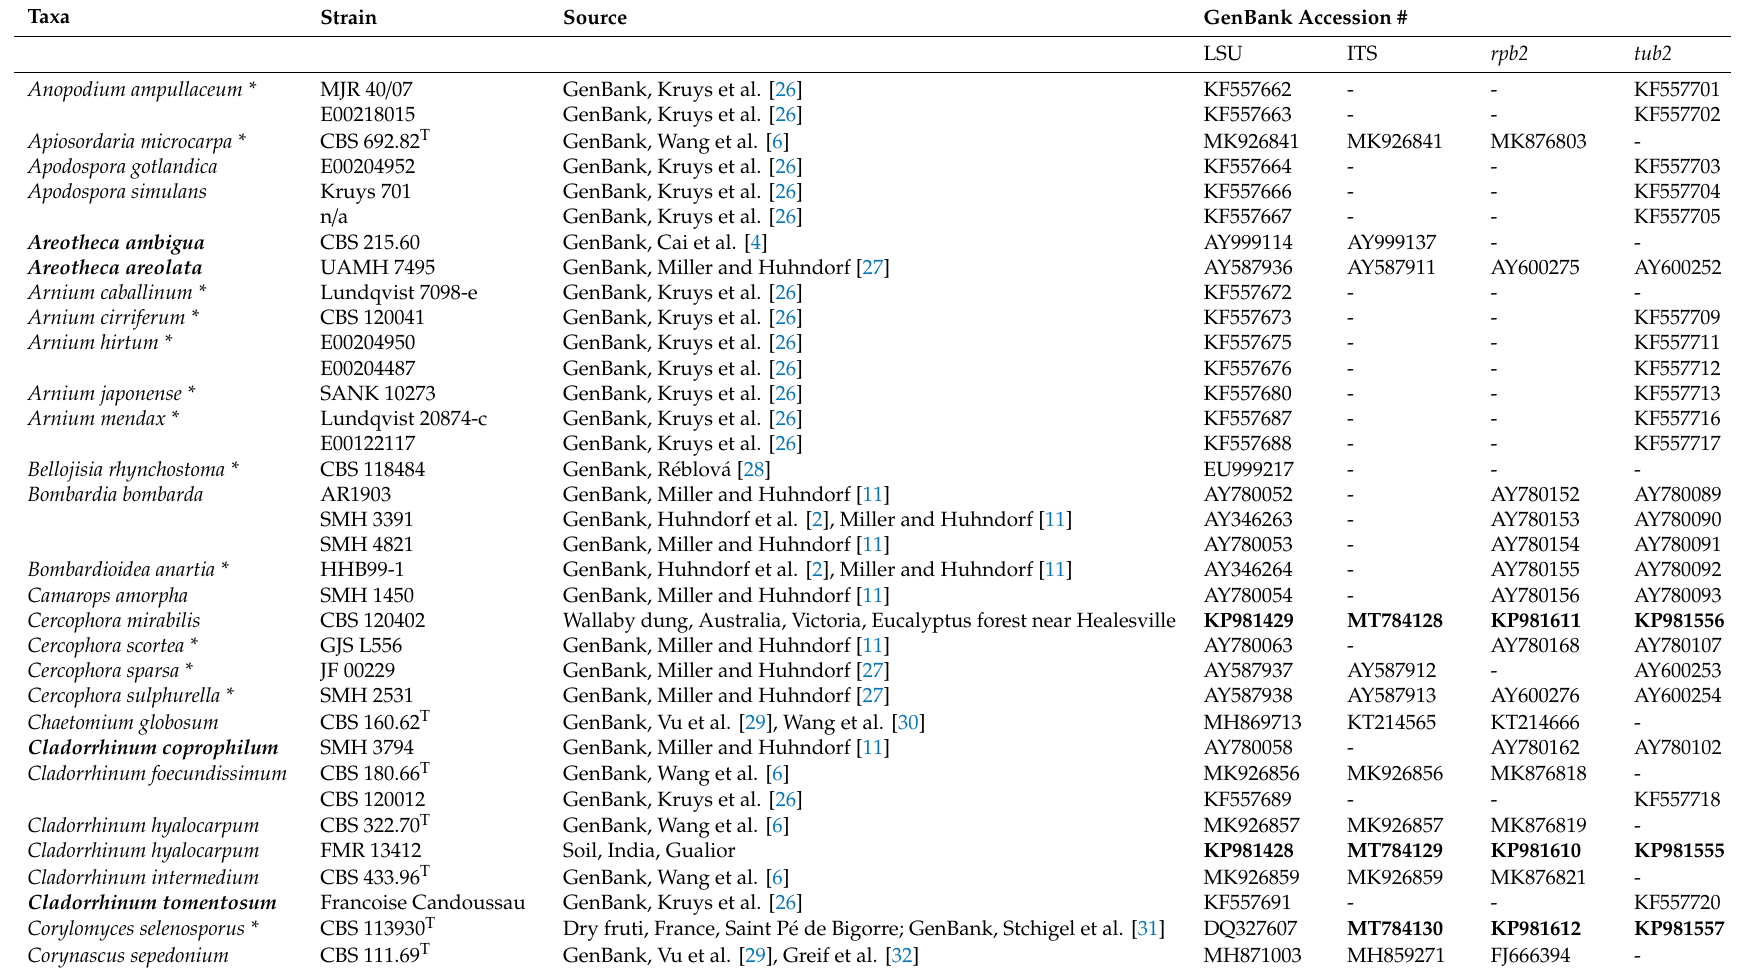
Table 1. Isolates and reference strains of the order Sordariales included in this study. # GenBank accession numbers in bold were newly generated in this study. Taxonomic novelties are indicated in bold italic